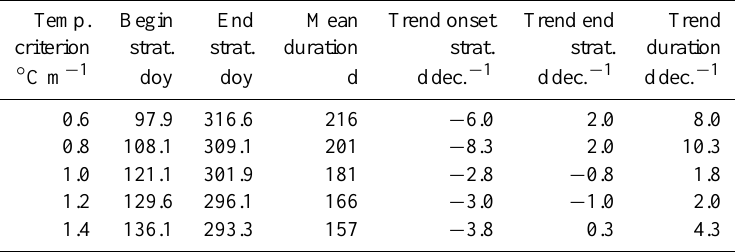
Table 7. Trends (1970–2010) and length of stratification period in the BSIOM output depending on different temperature criteria used to detect stable stratification. Temp.: temperature; strat.: stratification; doy: day of year; d: days; dec.: decade. Temp. Begin End Mean Trend onset Trend end Trend criterion strat. strat. duration strat.